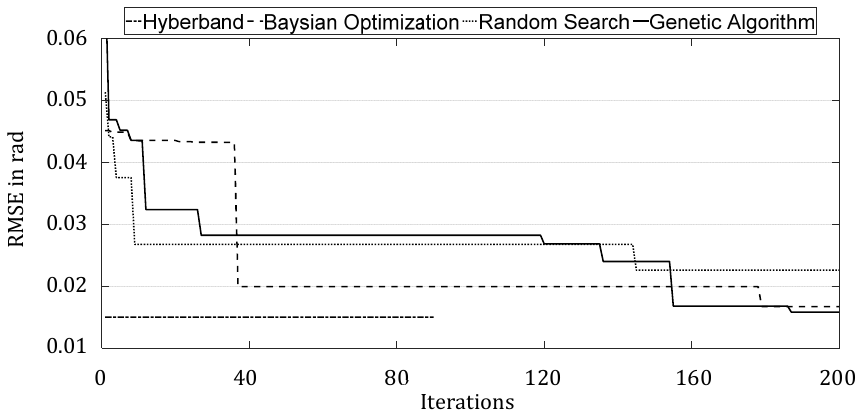
Figure 11. Comparison of best HPO results plotted over all iterations. Table 7. The 5 best parameter sets found by Random Search, Hyperband, Bayesian Optimization and Genetic Algorithm. RMSE Look- in rad